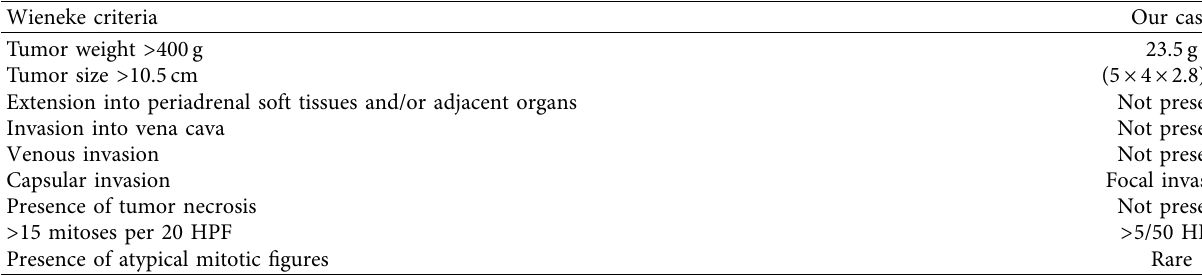
Figure 2: Grossly, encapsulated mass, no invasion to surroundings, size 5 × 4 × 2.8cm. Table 2: Wieneke index criteria in our patient.